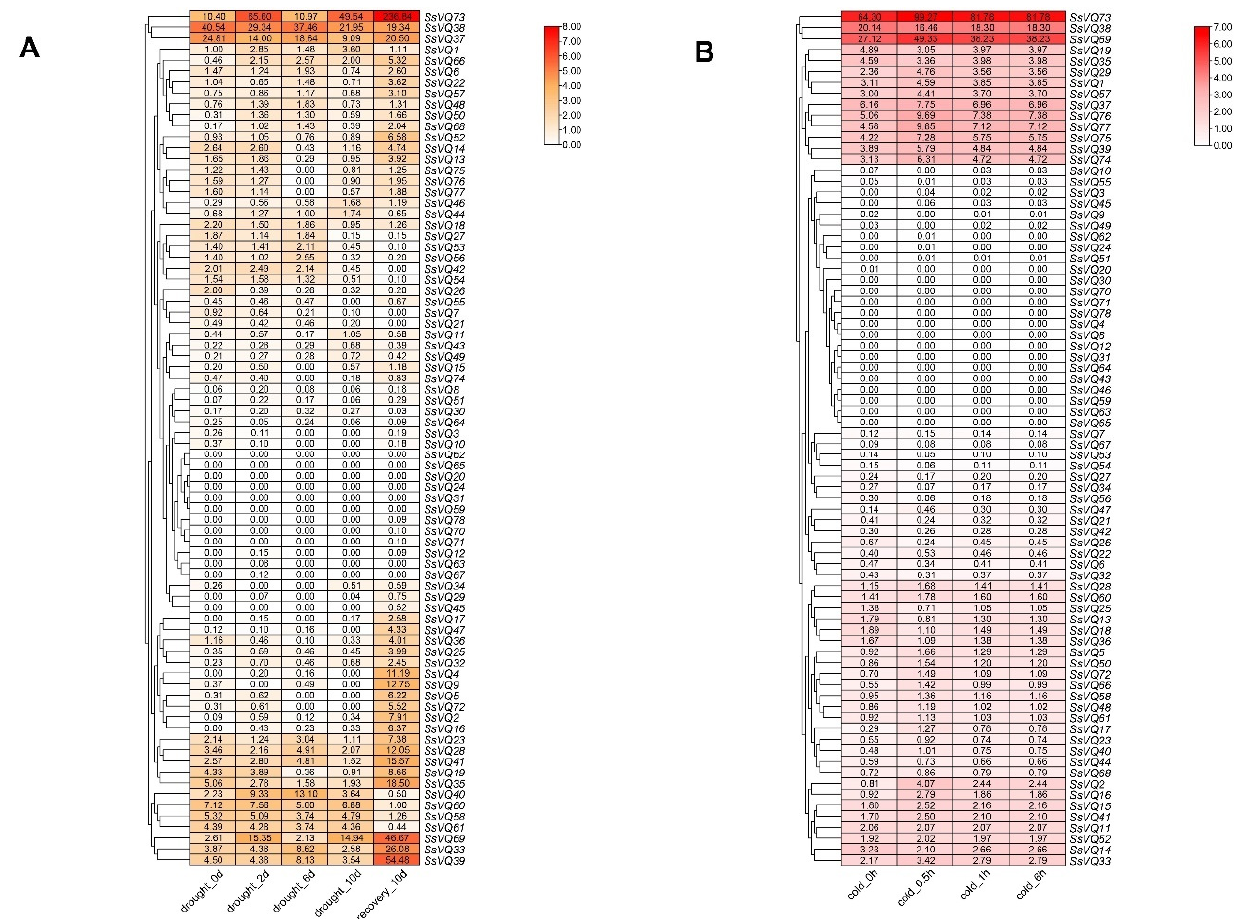
Figure 8. Expression profiles of SsVQs in response to drought and cold stresses. The number shown in the box is the original trimmed mean of M-values (TMM), which represent the expression levels of SsVQs . The color bar represented the normalized values (log 2 TMM). ( A ) The heatmap of SsVQ genes under drought stress. ( B ) The heatmap of SsVQ genes under cold stress.